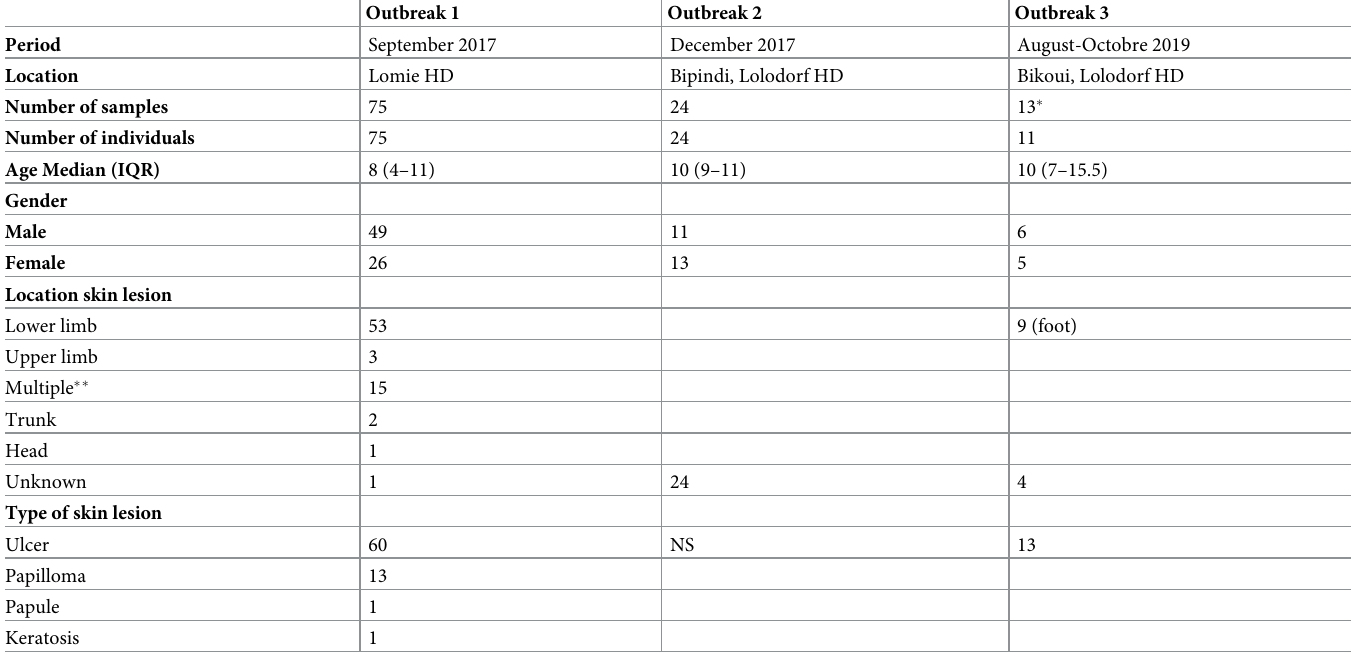
Table 2. Distribution of the samples according the outbreak’s location, age and gender of the individuals contributing to the samples and location of the skin